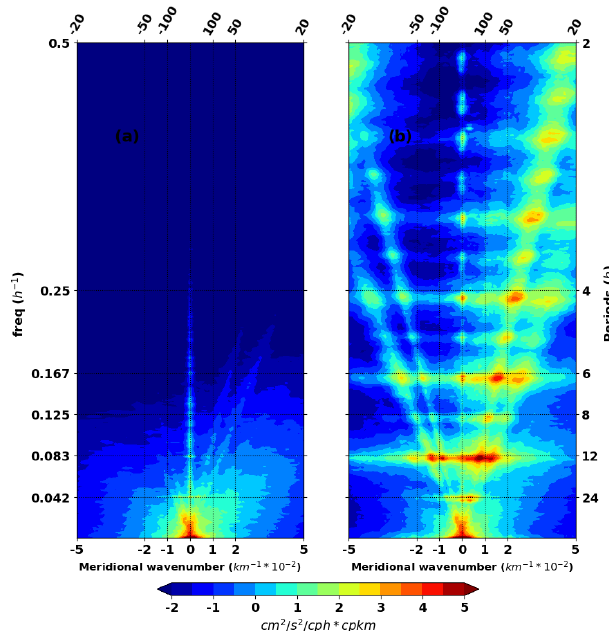
Figure 12. Meridional frequency–wavenumber of (a) the hourly SSH of the model without tide (NTSSH) and (b) the hourly SSH1 of the model with tide, both during MAMJJ. SSH1 is the residual between hourly total SSH and the coherent barotropic SSH. Spectra are evaluated within 0–10 ◦ N, 43–45 ◦ W and averaged over the lon- gitudes. Units: cm 2 s − 2 (cphcpkm) − 1 . Similar results are obtained for